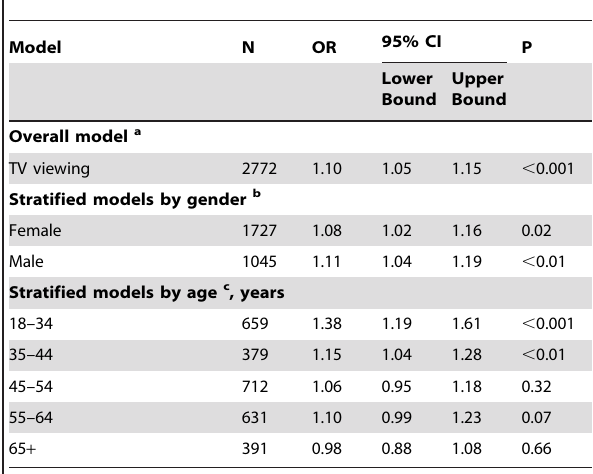
Table 3. Odds ratios (ORs) for obesity per hour increase in daily TV watching time by logistic regression